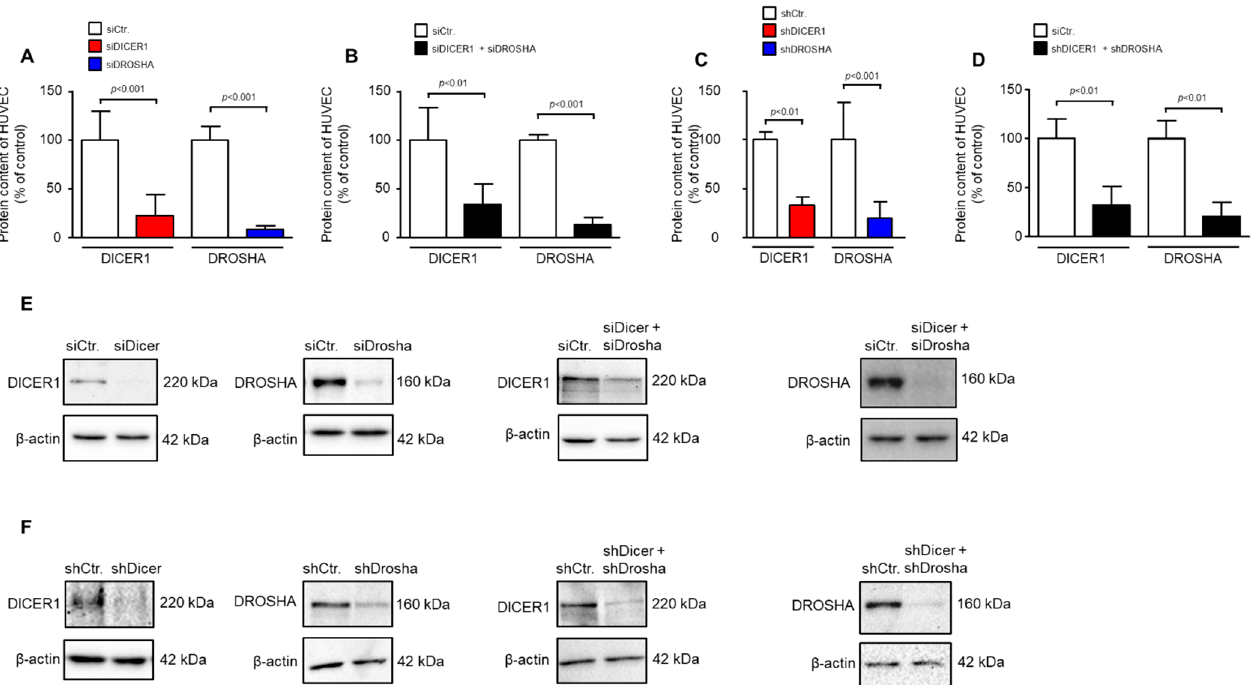
Figure 1. RNAi-mediated knockdown of DICER1 and/or DROSHA in HUVEC significantly reduces DICER1 and/or DROSHA protein content in these cells. ( A ) siRNA-mediated knockdown of either DICER1 or DROSHA or both ( B ) sig- nificantly reduces the respective protein content in HUVEC as evidenced by Western Blot detection ( n = 5–6 biological replicates from independent transfections). ( C ) shRNA-mediated knockdown of either DICER1 or DROSHA ( C ) or both ( D ) significantly reduces the respective protein content in HUVEC as evidenced by Western Blot detection ( n = 7–9 biological replicates from independent lentiviral transductions). Data are shown as mean ± SD. ( E , F ) For each analysis a representative Western Blot is shown for siRNA-mediated ( E ) and shRNA-mediated ( F ) knockdown.